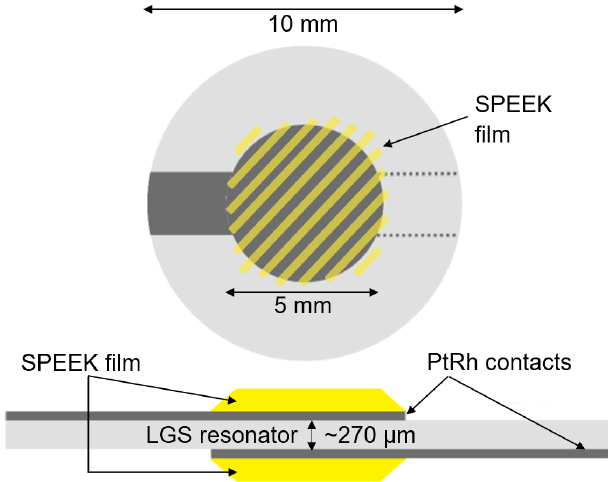
Figure 2. Scheme of the langasite resonator with electrodes and SPEEK films for hydration measurements. Note that the SPEEK film masses are detected with the nanobalance as well. See Sect. 3.2 for details.